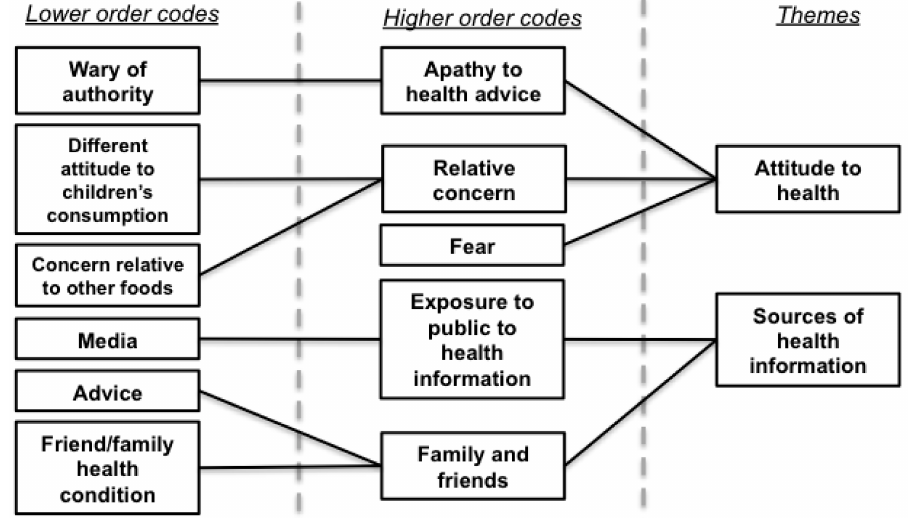
Figure 3. Hierarchical model of factors contributing to understanding the health effects of sugar